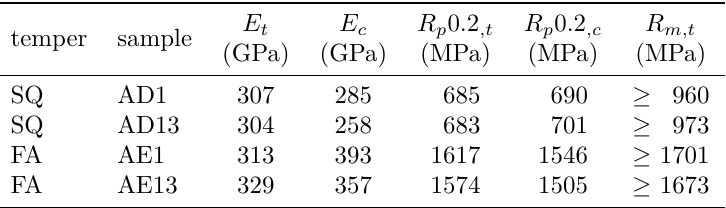
Table 1. Mechanical properties of individual specimens obtained by four point bending. Subscripts c and t denote tension and compression respectively.